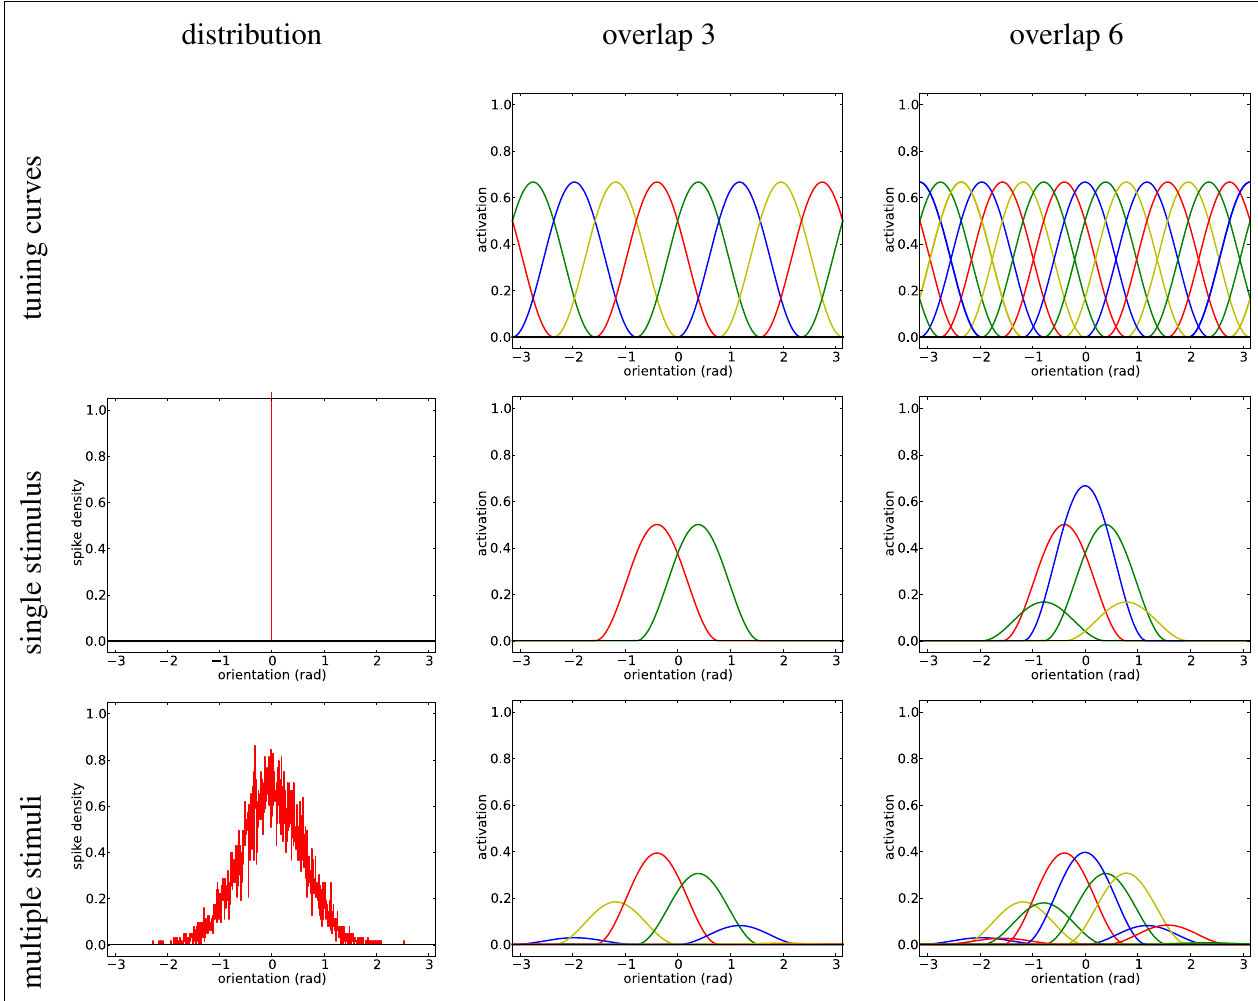
means of weighted basis functions) of a single stimulus (impulse, cf. left column), and the third row shows the encoding of multiple stimuli (Gaussian distribution, cf. left